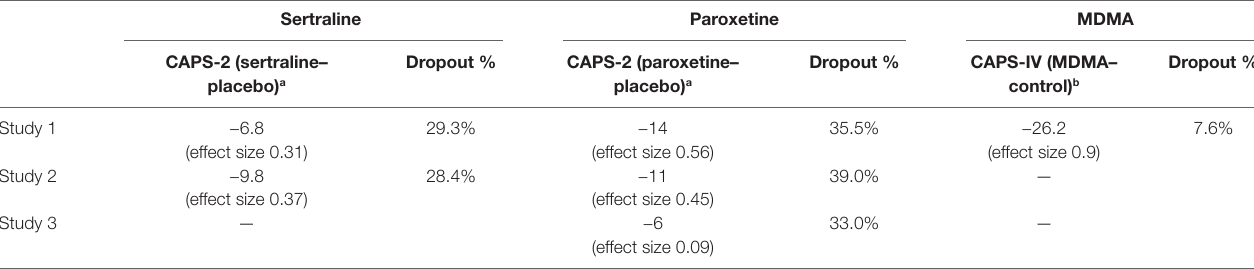
TABLE 3 | Comparison of sertraline, paroxetine, and MDMA mean CAPS reduction LOCF, intent-to-treat. Sertraline Paroxetine